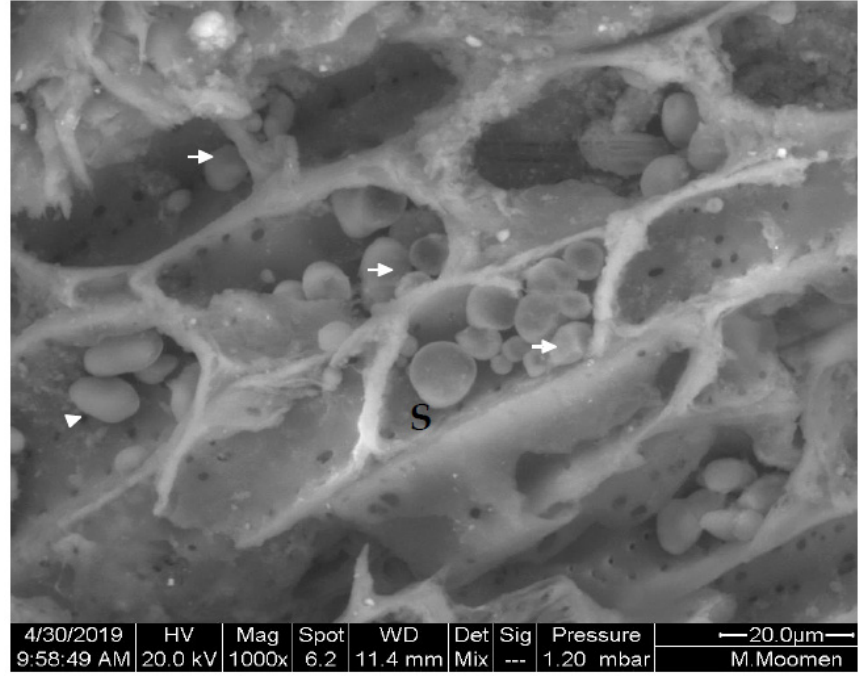
Figure 8. ESEM micrograph of stem cross section in Sakasly cultivar revealing deposition and a dense accumulation of starch grains (S) (white arrows) in parenchymatic pith (A).